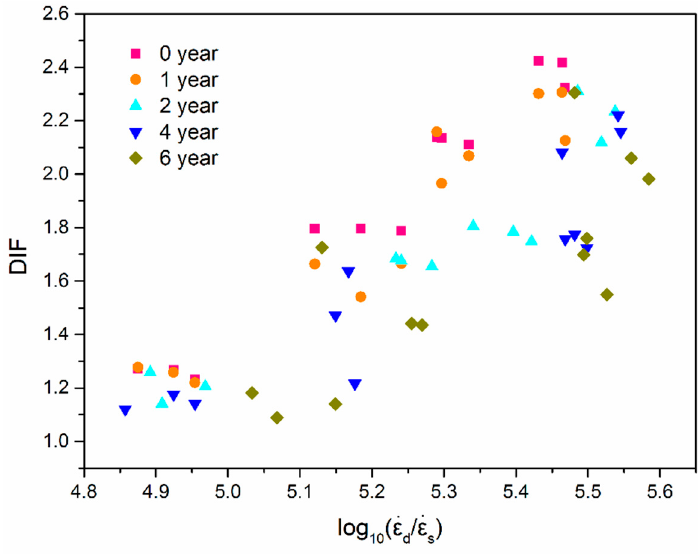
. . ε d / ε s ) ε ε   . Figure 14. The scatter of the DIF with log 10 ( log ( ) 10 d s